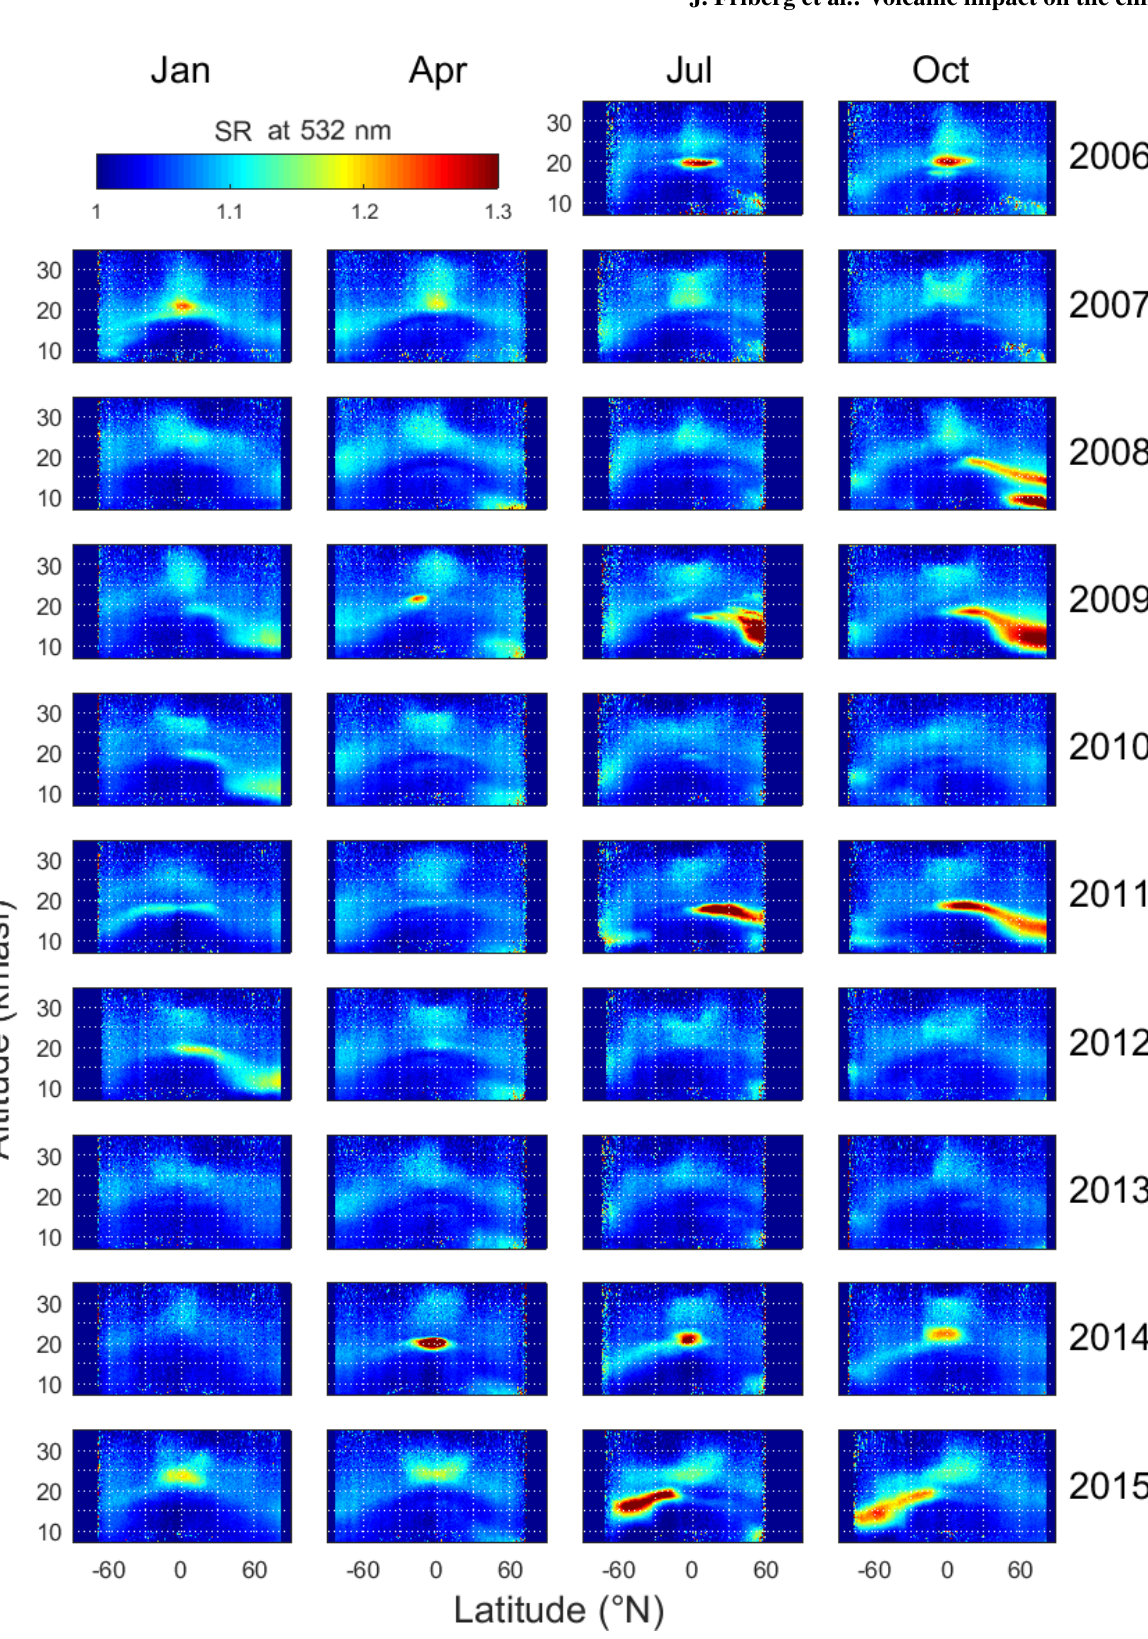
Figure 4. Monthly mean scattering ratio as a function of latitude and altitude (7–35km) in the months January, April, July, and October